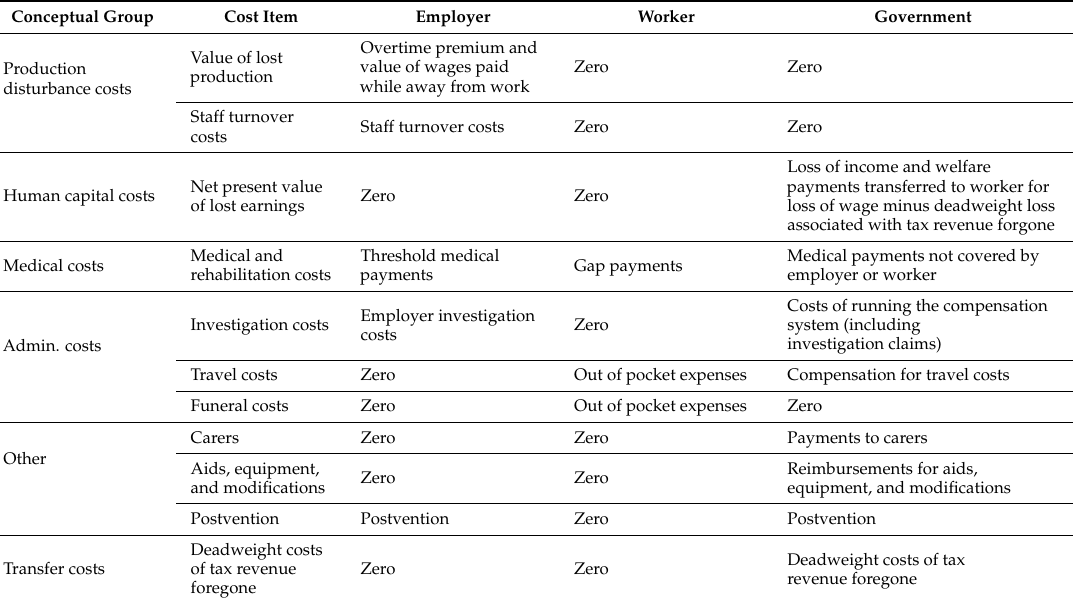
Table 2. Economic cost borne by the employer, worker, and